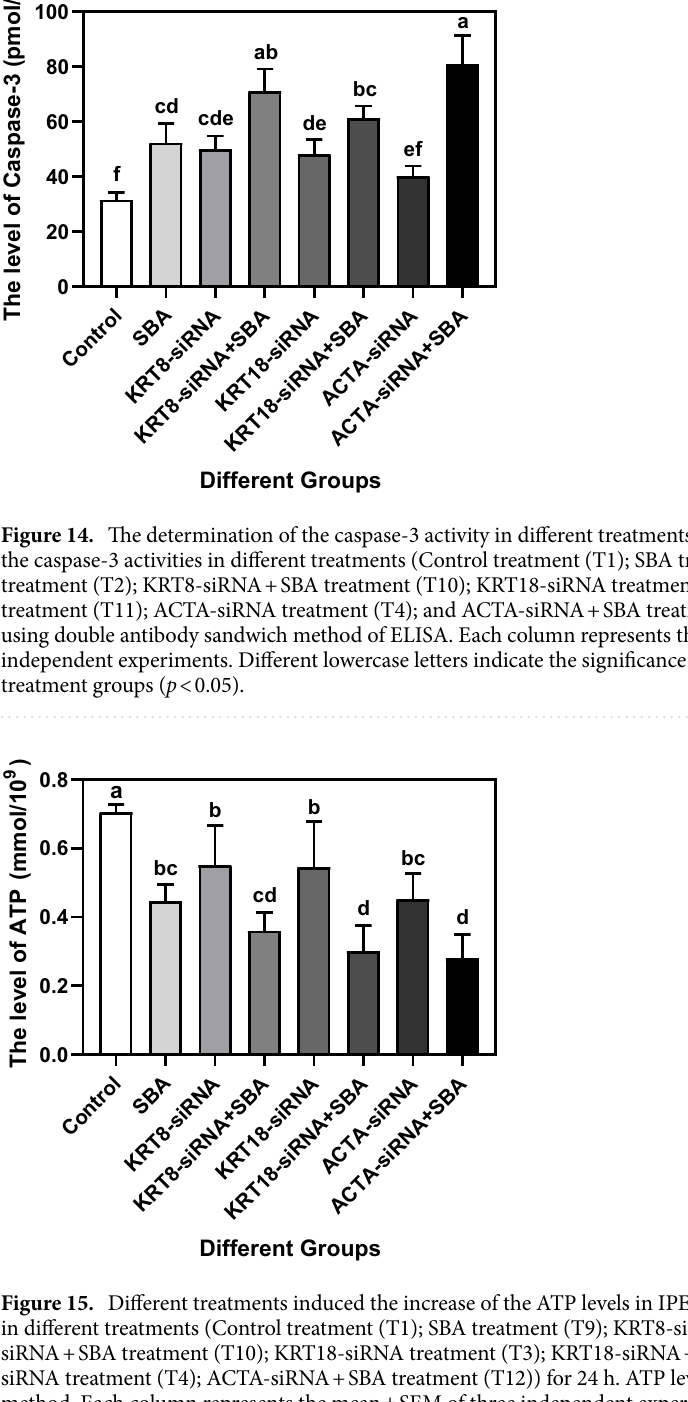
SBA‑induced cell apoptosis through the cytoskeleton‑external apoptosis signal pathway. The effects of SBA and cytoskeletal proteins (KRT8, KRT18 and ACTA) on the death receptor pathway of apoptosis were investigated. The results showed that T9 and three cytoskeletal proteins-siRNA treatments (T2, T3 and T4) had higher expression levels of FasLG protein (Fig. 18 (Figs. S23 and S24) and Fig. 19B) and membrane FADD expression (Fig. 18 (Figs. S27 and S28) and 19D) compared to the T1 ( p < 0.05). There was a corresponding reduction in the levels of the caspase-8 expression (Fig. 18 (Figs. S22 and S24) and 19A) ( p < 0.05). Even the cytoplasm FADD expression (Fig. 18 (Figs. S25 and S26) and Fig. 19C) and the caspase-8 (Fig. 20) activity in